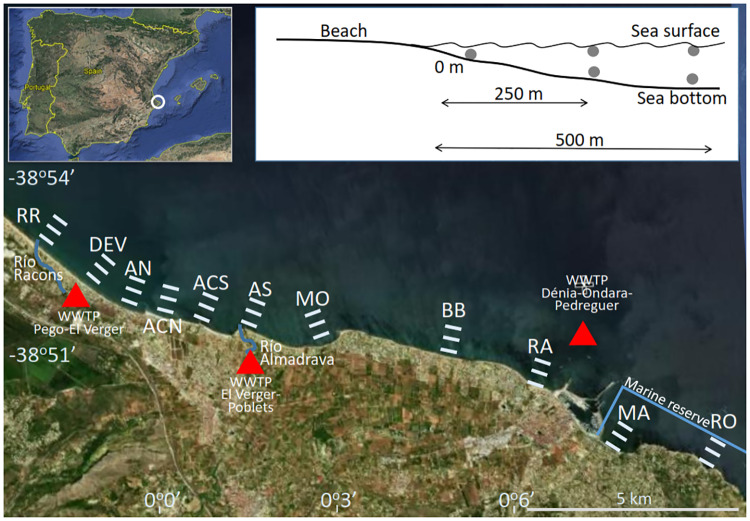
Sampling area for Carybdea marsupialis cubomedusae off Spain in the western Mediterranean.Sampling stations (white lines): RR: Racons River, DEV: Deveses, AN: Almadrava Norte, ACN: Almadrava Centro-Norte, ACS: Almadrava Centro-Sur, AS: Almadrava Sur, MO: Molins, BB: Blay Beach, RA: Raset, MA: Marineta, RO: Rotas. WWTP: Waste water treatment plant discharge point (triangles). Base image from the Instituto Geográfico Nacional CC BY 4.0 http://www.ign.es/web/resources/docs/IGNCnig/FOOT-Condiciones_Uso_eng.pdf.